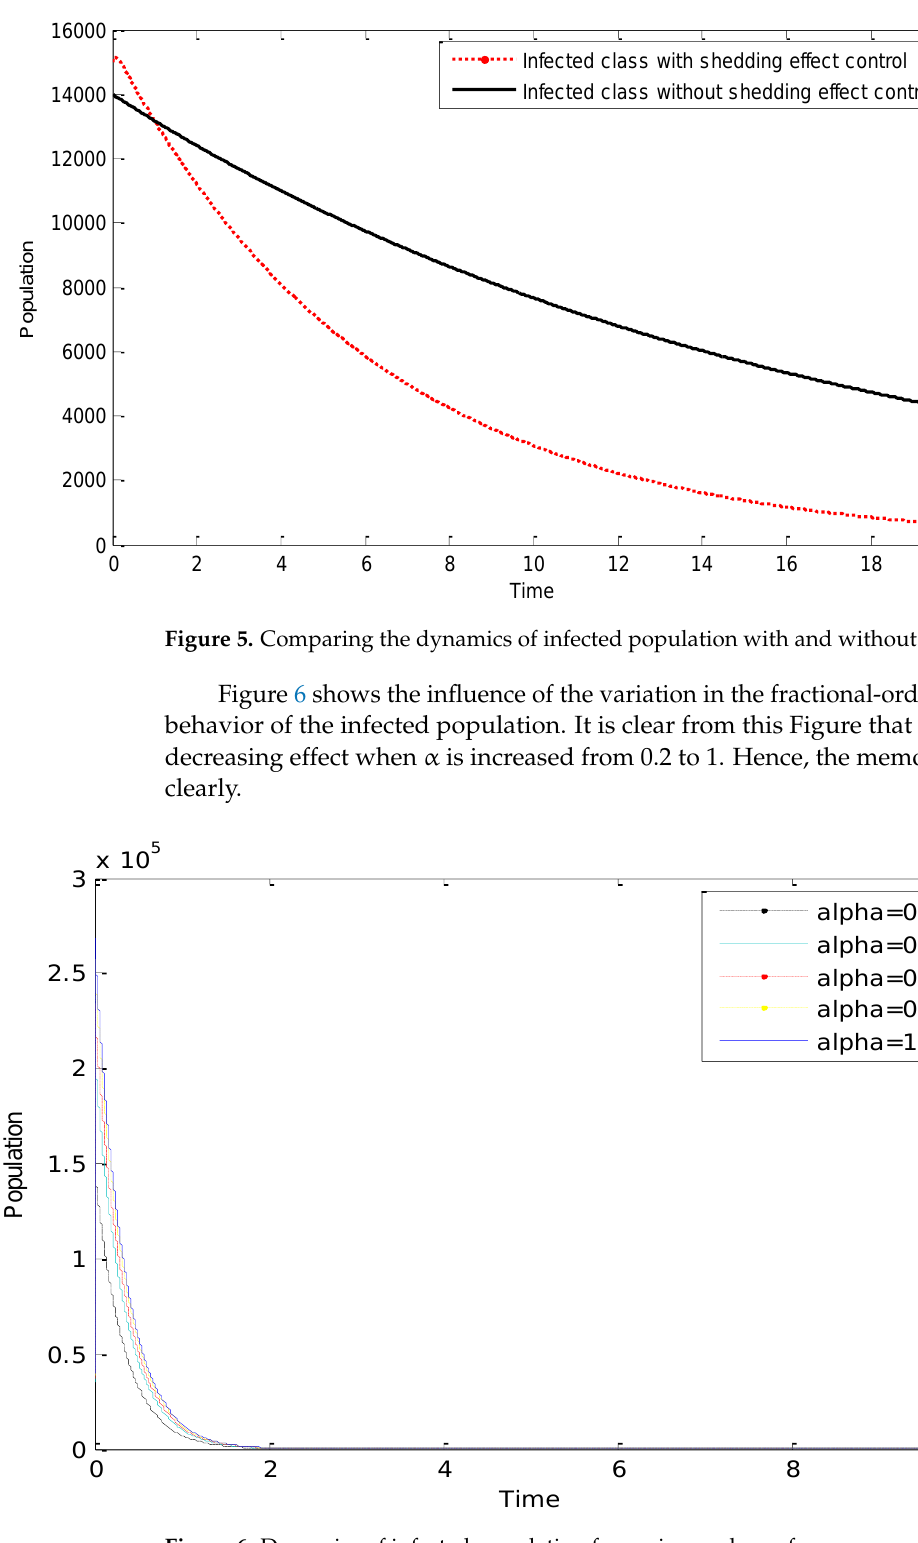
Figure 6. Dynamics of infected population for various values of α .